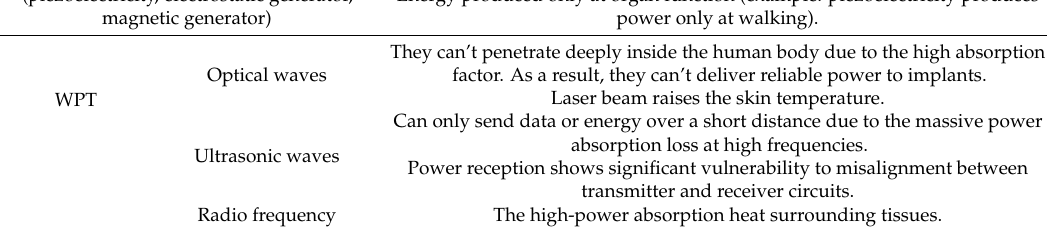
Limit patient mobility. Tissue infection. Short lifetime. Surgical operations necessity. Big size. Skin